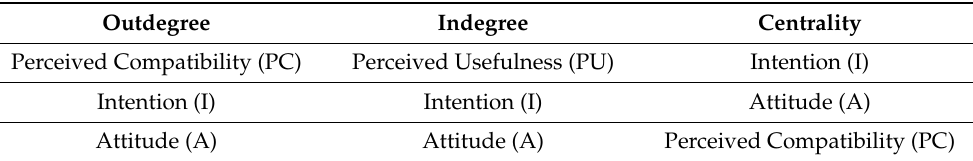
Table 4. Factors with higher centrality, outdegree and indegree